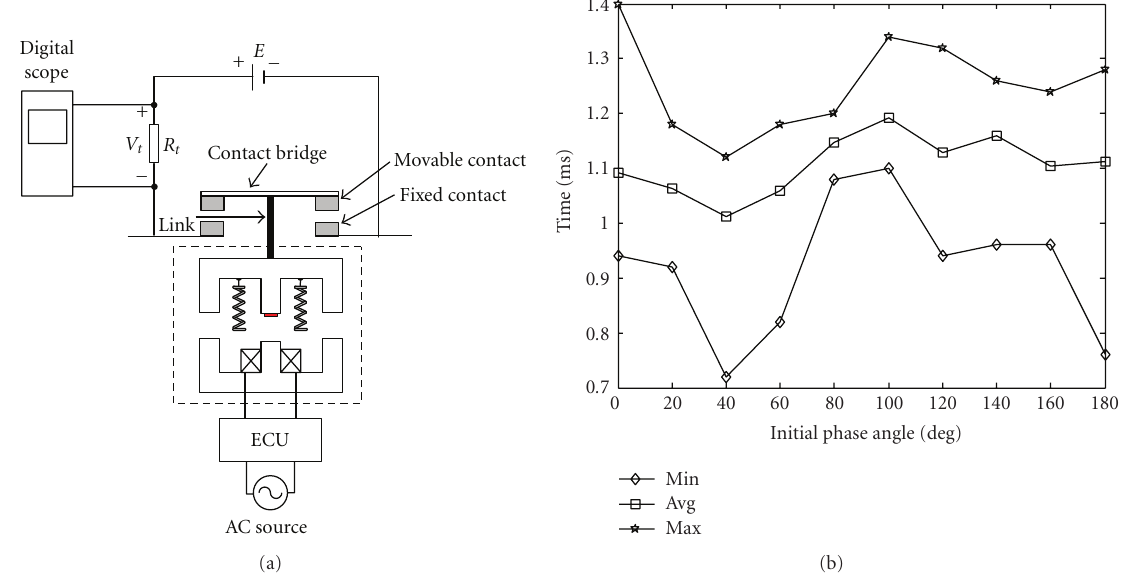
Figure 11: It shows (a) a testing rig for measuring the bouncing duration of contact after two contacts impact (b) measured results.